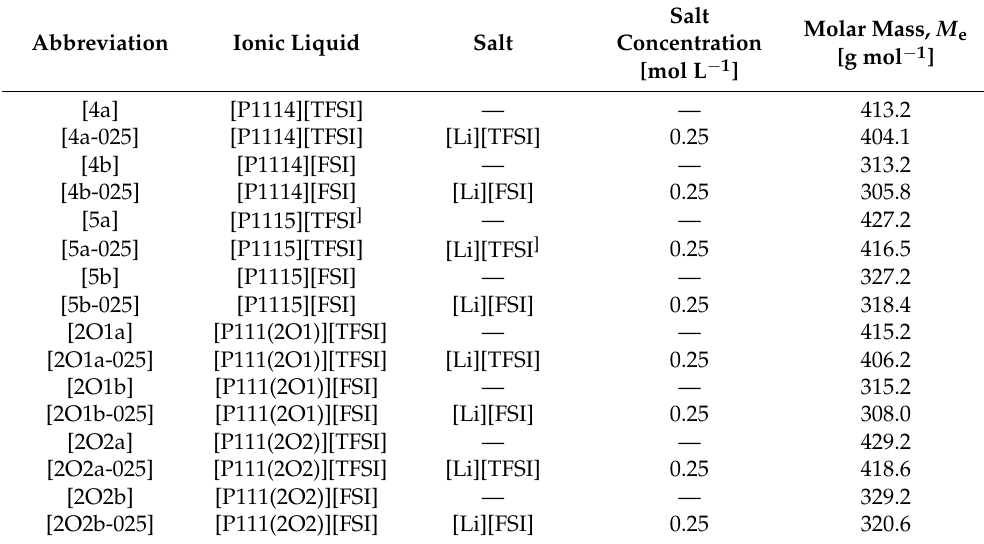
Table 1. Overview of ionic liquids and electrolytes. The abbreviation was chosen for labeling the samples in the manuscript. “a” mentions the [TFSI] − anion, and “b” is used when [FSI] − salt is